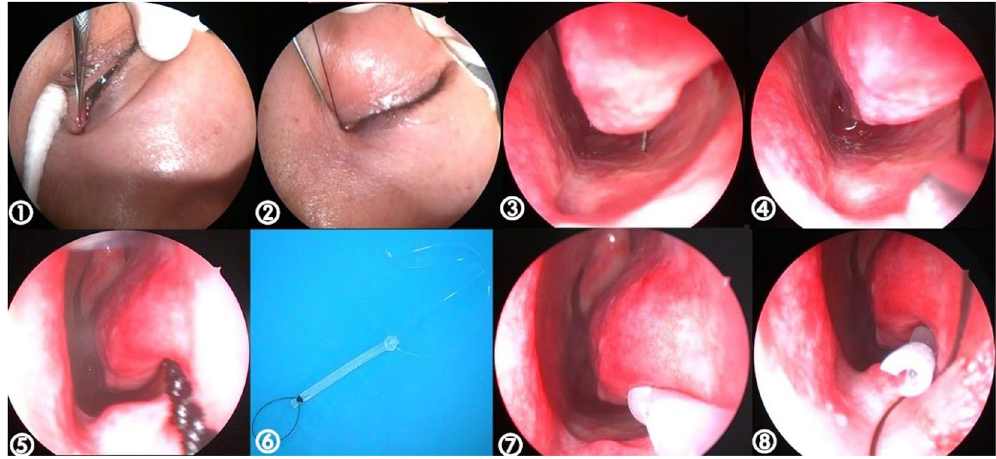
Figure 3. RSHSI performed under nasal endoscopy ( ① ~ ⑧ ). No. ⑥ shows the spherical silicone tube (Guanghzhou BoShi health-care Institution: hollow circular, 3.5 cm long, 4.2 mm in diameter of spherical end, 2.5 mm in diameter of the duct, a 90 mm ± 10 mm circle line in the head, a 15 mm ± 5 mm long line in the tail, registration certificate number was